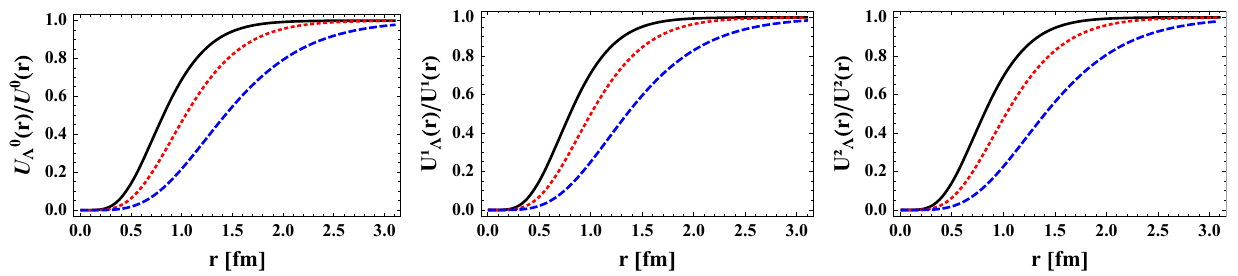
√ s = 2 m π as a function of the distance for I = 0 (left), I = 1 (middle)